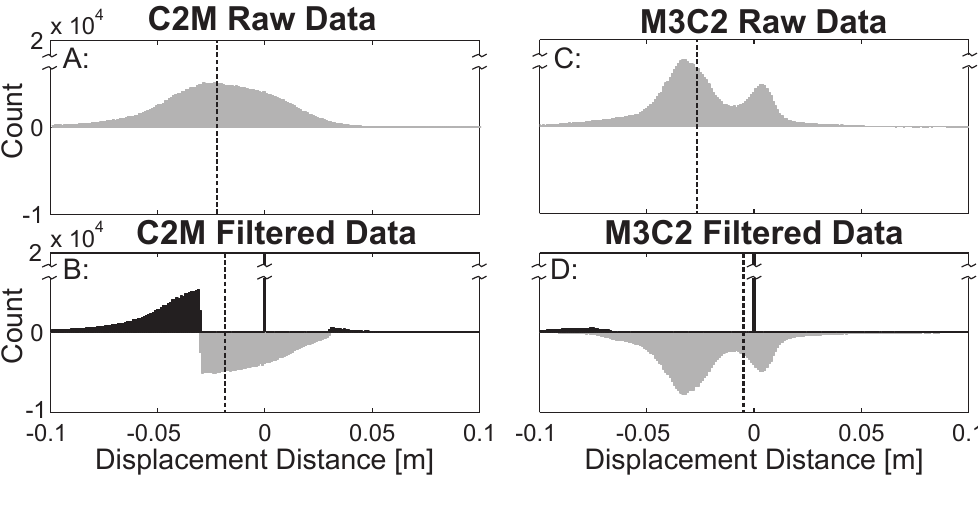
Figure 4. Histograms illustrating how displacements between 2012 scans no. 3 and 4 were processed using both C2M and M3C2. Dashed lines indicate the mean of each data set. ( A ) Raw C2M displacement data before filtering. Mean displacement is − 0.023 m. ( B ) Filtered C2M displacement data. The hanging gray portion indicates displacements considered insignificant and converted to zero. The black portion indicates remaining displacements after filtering. Note that C2M uses a blanket detection threshold, which is reflected in the hard transitions between the black and gray portions of the histogram. Mean displacement is − 0.019 m, and 61% of the raw displacements are considered insignificant. ( C ) Raw M3C2 displacement data before filtering. Mean displacement is − 0.026 m. ( D ) Filtered M3C2 displacement data. The hanging gray portion indicates displacements converted to zero. Black portion indicates remaining displacements after filtering. Note that M3C2 utilizes a spatially variable confidence interval (SVCI), which is reflected in the overlapping portions of the black and gray distributions. Mean displacement is − 0.005 m, and 95% of the raw displacements are considered insignificant displacements.